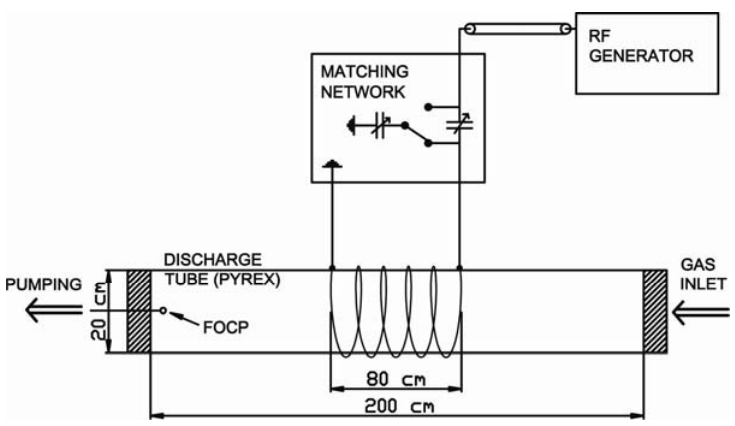
Figure 3. Experiment